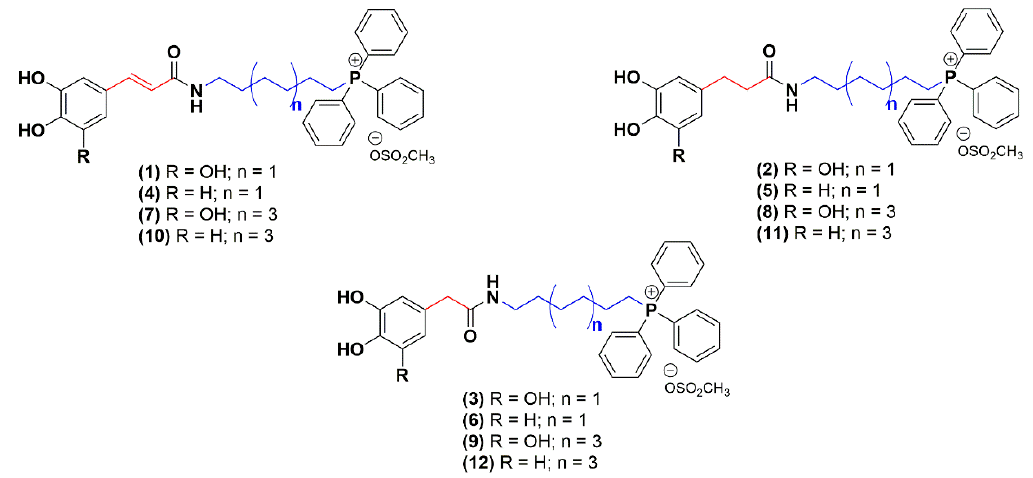
Figure 2. Chemical structures of mitochondriotropic antioxidants used in this work.